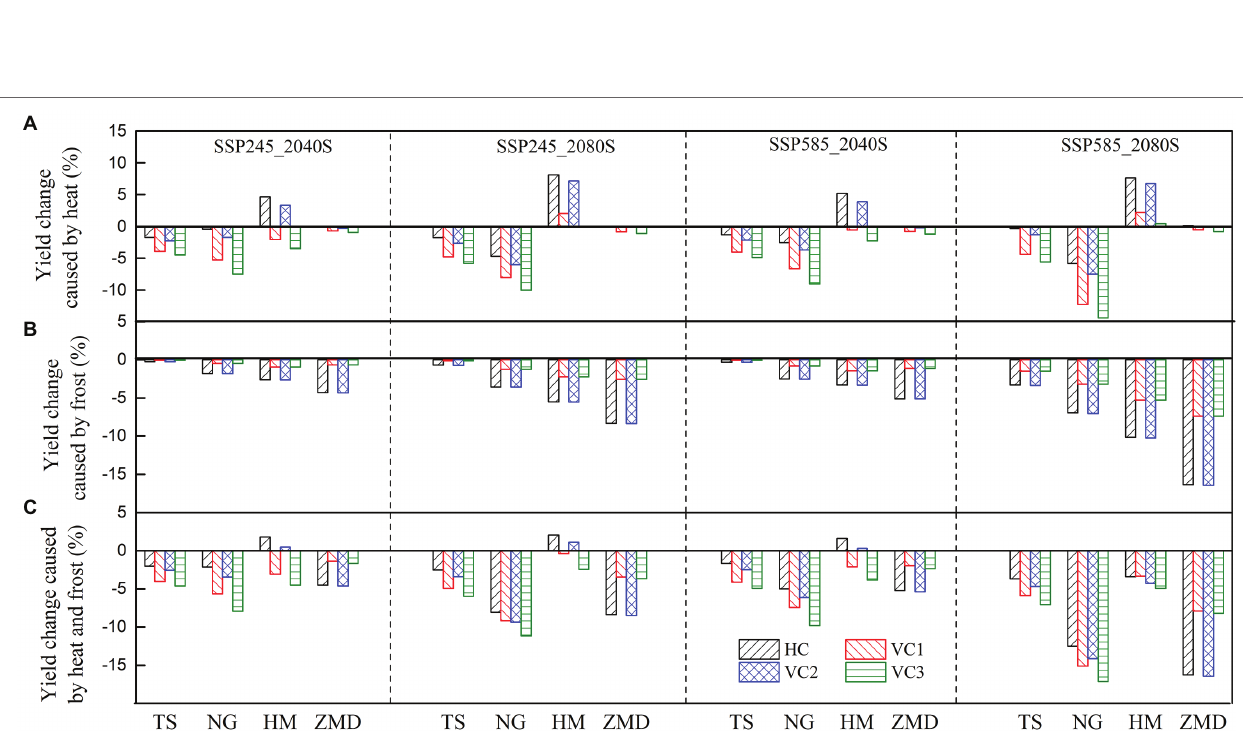
FIGURE 6 | Changes in impacts of heat (A) , frost (B) , heat and frost stress (C) on wheat yield in the 2040S and 2080S under SSP245 and SSP585 scenarios compared to the baseline period (1981–2010). Black rectangles represent multi-model mean values from simulations with optimum adaptation.